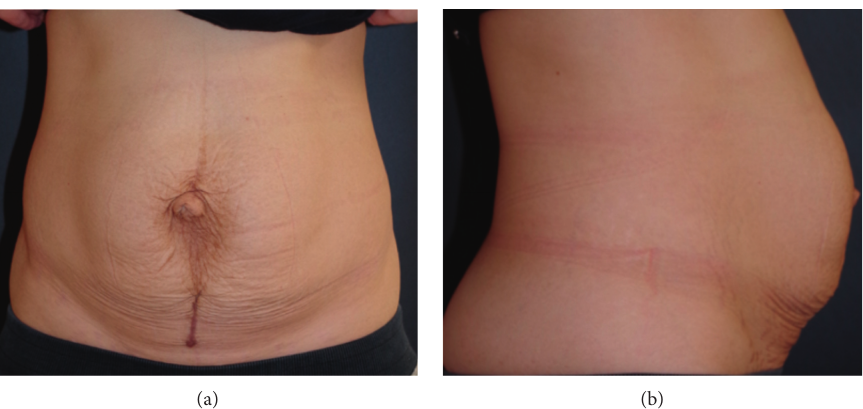
Figure 1: A 5 cm vertical surgical scar is present distal to the umbilicus. Significant midline abdominal bulging is noted to extend beyond the level of the scar.